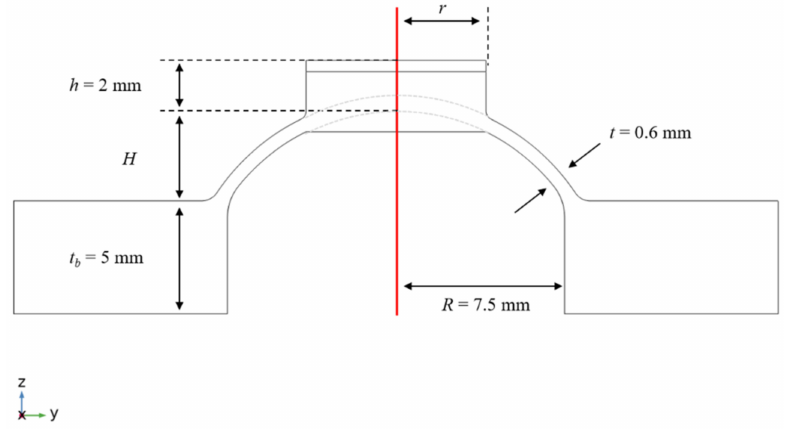
Figure 10. Two-dimensional (2D) sketch of the dome, containing the set geometric